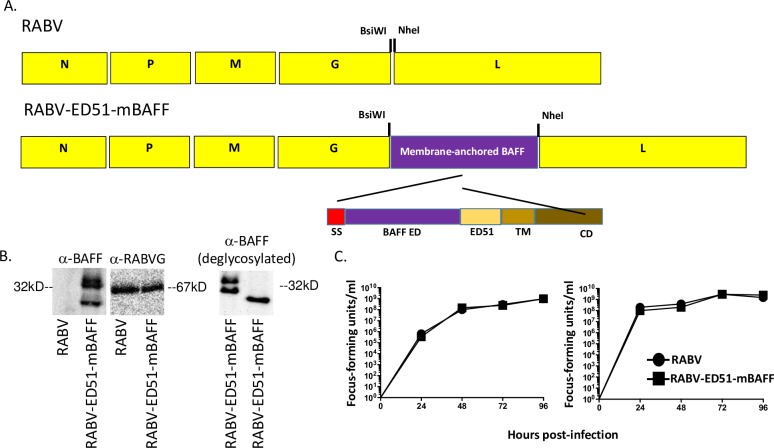
Construction and characterization of a recombinant RABV-based vector displaying virus membrane-anchored BAFF (RABV-ED51-mBAFF).(A) RABV is a molecular clone of the attenuated vaccine strain of RABV, SAD-B19. The gene encoding ED51-mBAFF from pcDNA-ED51-mBAFF (Fig 1) was digested with BsiWI and NheI and then ligated into pRABV previously digested with BsiWI and NheI, resulting in pRABV-ED51-mBAFF. Infectious virus was recovered and named RABV-ED51-mBAFF. (B) To analyze incorporation of ED51-mBAFF into RABV-ED51-mBAFF virions, sucrose-purified RABV or RABV-ED51-mBAFF particles were separated by SDS-PAGE and transferred to a nitrocellulose membrane. Blots were probed with either an anti-BAFF antibody (left panel) or anti-RABV G antibody (right panel). (C) BSR cells were infected with RABV or RABV-ED51-mBAFF at a MOI of 5 (one-step growth curve, right panel) or 0.01 (multi-cycle growth curve, left panel). Aliquots of tissue culture supernatants were collected at various times post-infection and viral titers were determined in duplicate.